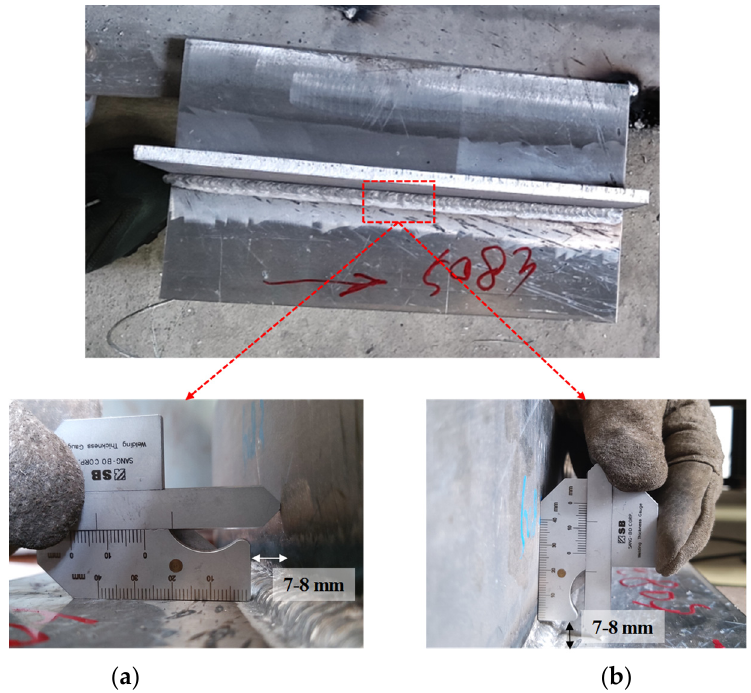
Figure 4. Leg length of fillet welding: ( a ) Bottom leg length; ( b ) Upper leg length.